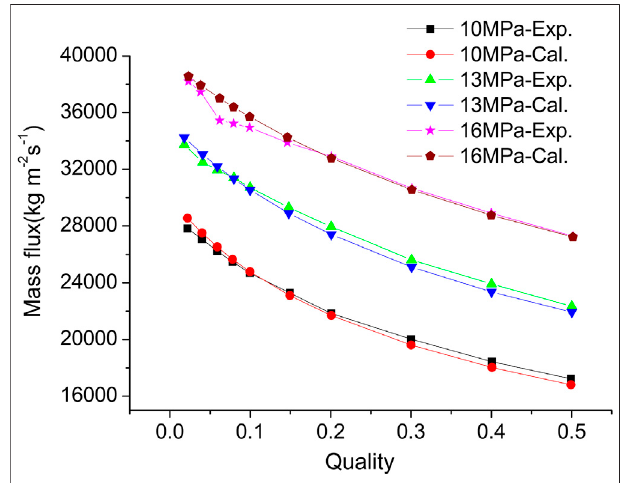
FIGURE 7 | Comparison of model prediction with experiment data (saturated